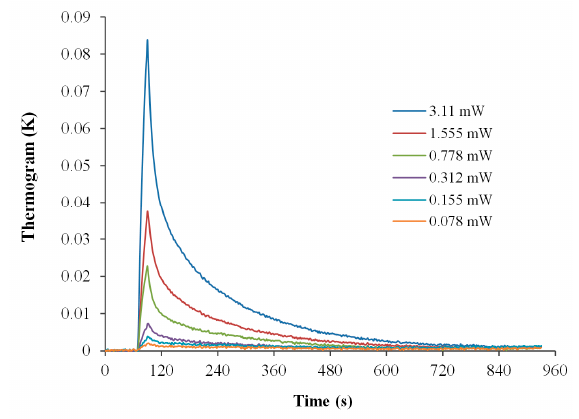
Figure 4. Joule heating pulses (20 s) response of the proposed multichannel calorimetric simultaneous assay platform in “mK” mode (10-fold gain IA amplifier). Baseline temperature drift rate was 4 µK/s between measurements.